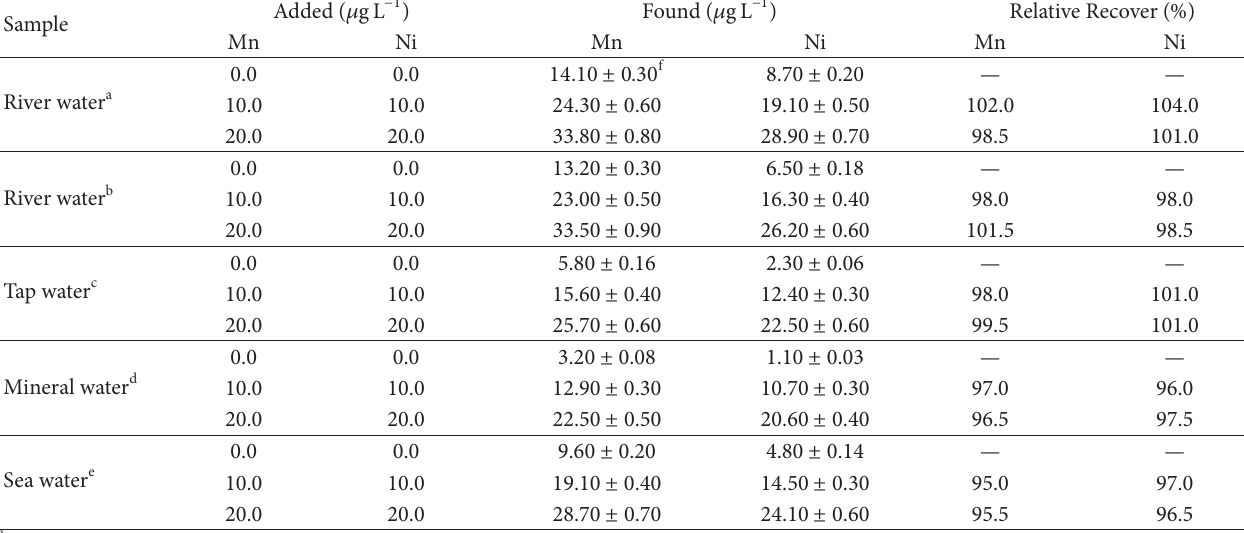
T 4: Determination of Ni (II) and Mn (II) in natural water samples (